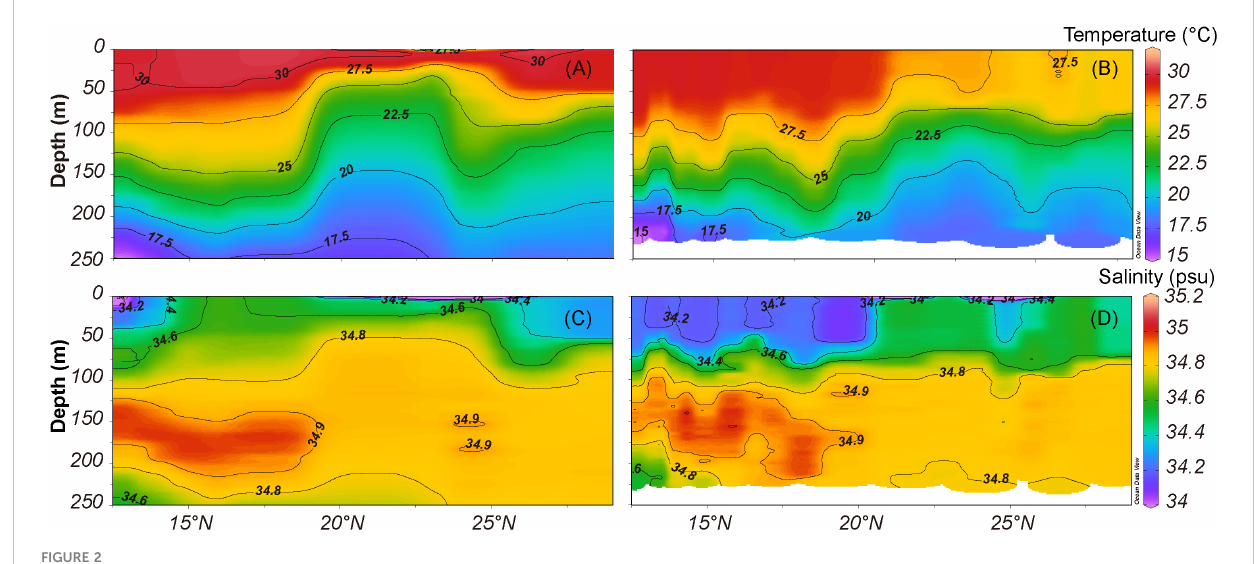
FIGURE 2 Temperature pro fi le and salinity pro fi le along 135°E in summer (A, C) and autumn (B, D)